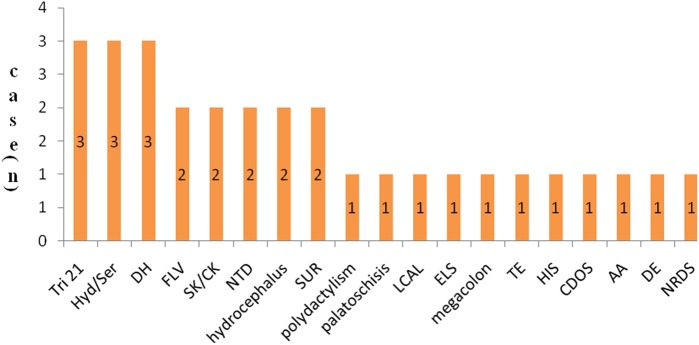
Spectrum of associated malformations in a non-selected population of 53313 PIs.Tri 21: trisomy 21 syndrome; SUR: single umbilical artery; Hyd/Ser: hydrothorax/seroperitoneum; DH: diaphragmatic hernia; FLV: fetal lateral ventriculomegaly; SK/CK: single kidney/compound kidney; NTD: neural tube defect; LCAL: lung cystic adenomatoid lesion; ELS: enlargement of the liver and spleen; TE: talipes equinovarus; HIS: internal heterogeneous syndrome; CDOS: congenital dysplasia of the skin; AA: accessory auricle; DE: diaphragmatic eventration; NRDS: neonatal respiratory distress syndrome.